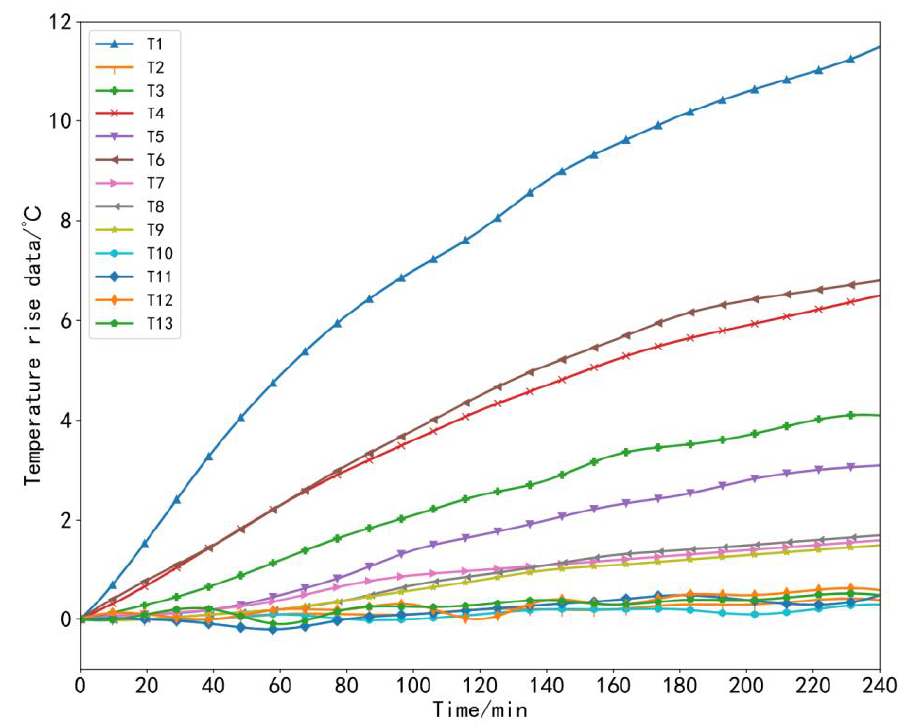
Figure 9. Temperature rise data at a speed of 2000 mm/min.